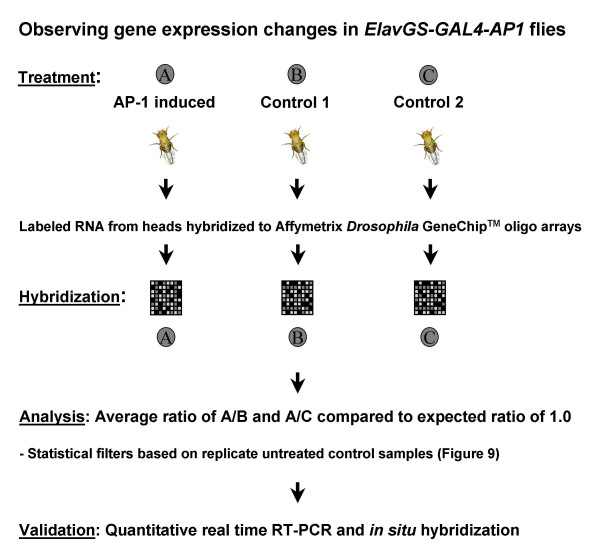
Microarray experimental design, analysis and validation. To induce AP-1 in the nervous system, 1–3 day old adult ElavGS-GAL4-AP1 flies were treated with the synthetic steroid hormone RU486 in 2% sucrose or sucrose alone for six hrs. Biotinylated RNA from heads was created and hybridized to Affymetrix Drosophila Genome1 GeneChip arrays. Gene expression changes between AP-1 induced and control samples were considered significant if they passed a statistical (P < 0.01, Student's t-test) and secondary filters looking at variance in untreated control samples from the same experiment. Validation of candidate gene expression changes was carried out using quantitative real-time RT-PCR and in situ hybridization experiments.